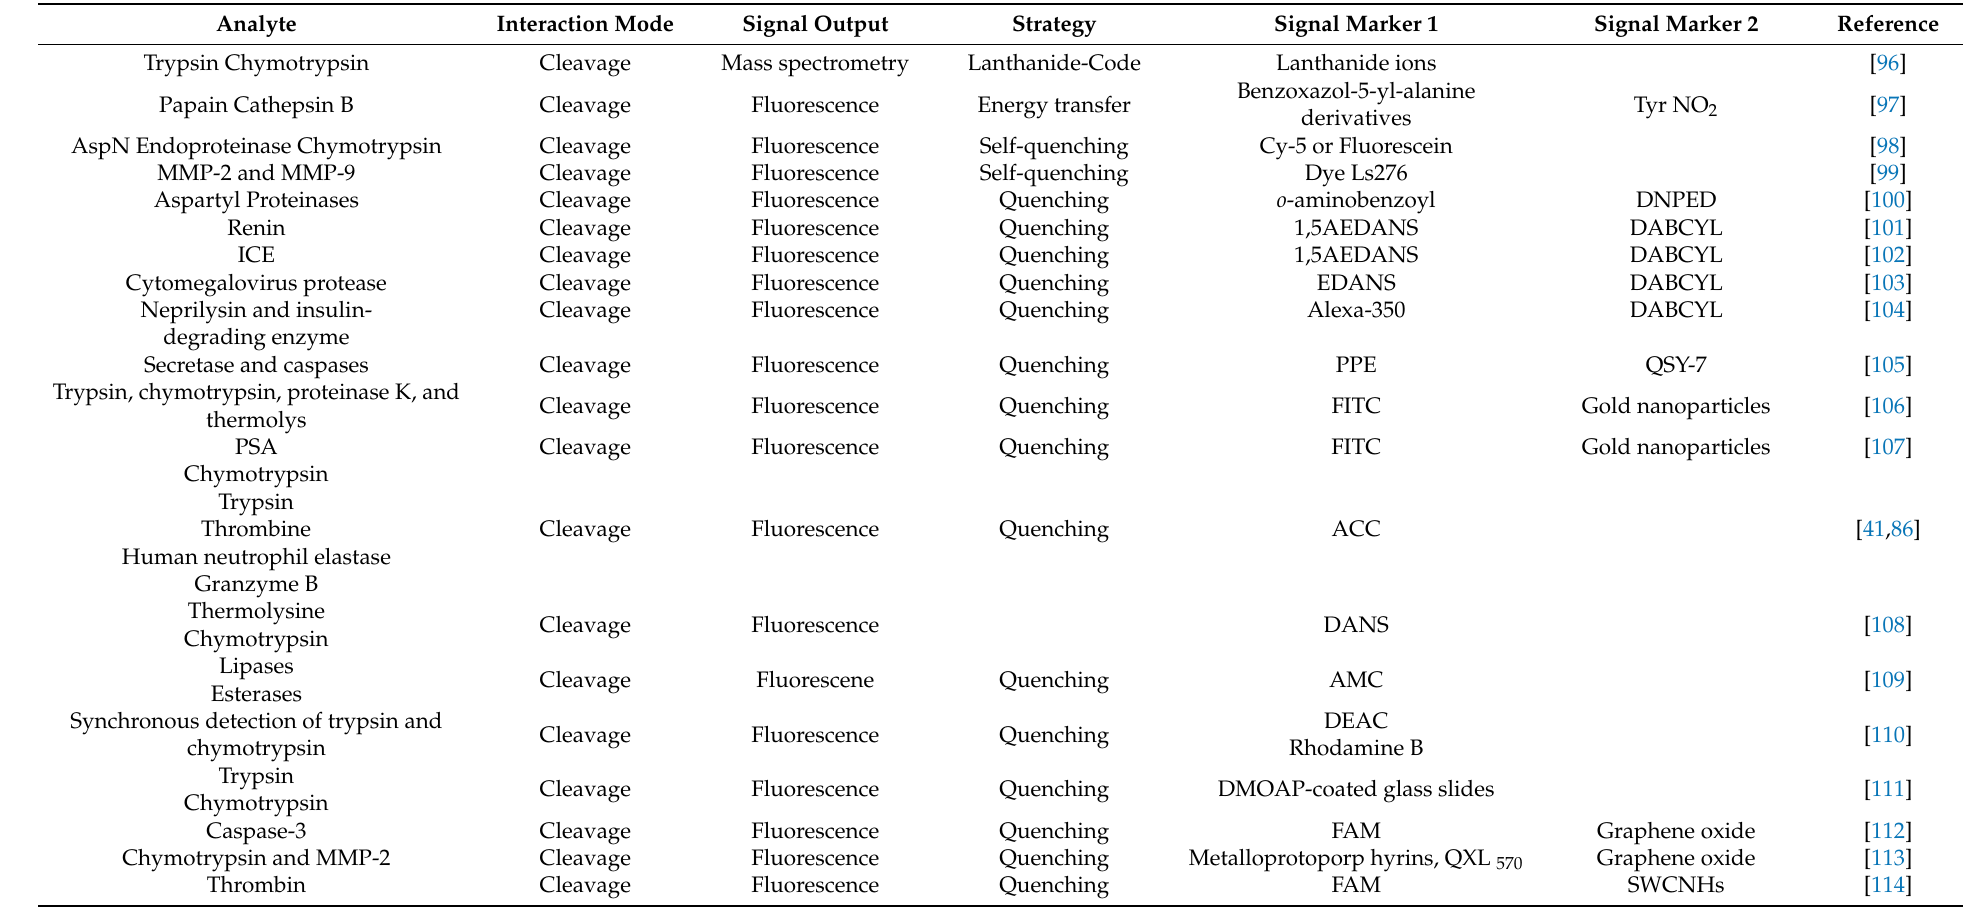
Table 1. Peptide-based protease sensors. ICE: Interleukin 1 beta converting enzyme; DNS: 5-(Dimethylamino) naphthalenesulfonamide (DANSYL); DABCYL: 4-(4- N,N -dimethylaminophenyl)azobenzoic acid; FITC: Fluorescein isothiocyanate; 1,5AEDANS: 5-((2-Amino-ehyl)amino)-naphthalene-1-sulfonic acid;